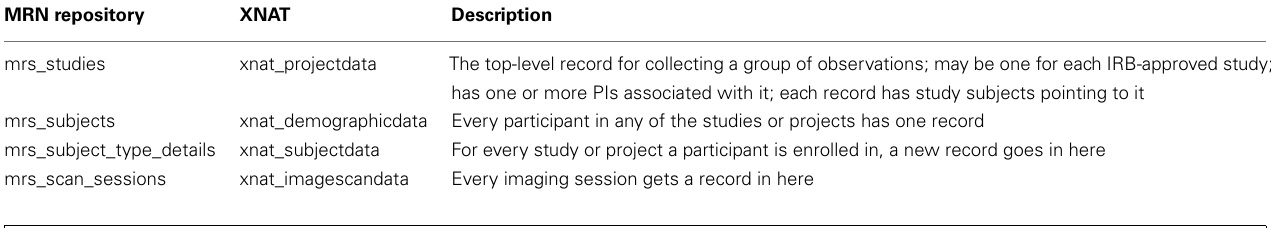
Table 3 |Tables in the MRN Repository and XNAT that store equivalent information.